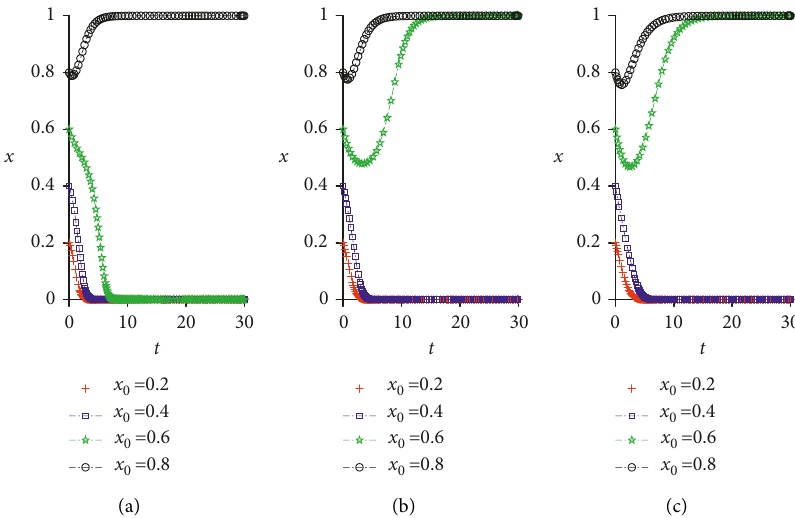
Figure 6: Impact of π on system evolution. Comparing (a), (b), and (c), as π s s independently) increases, the probability of the system evolving to the ideal state increases. (a) π ′